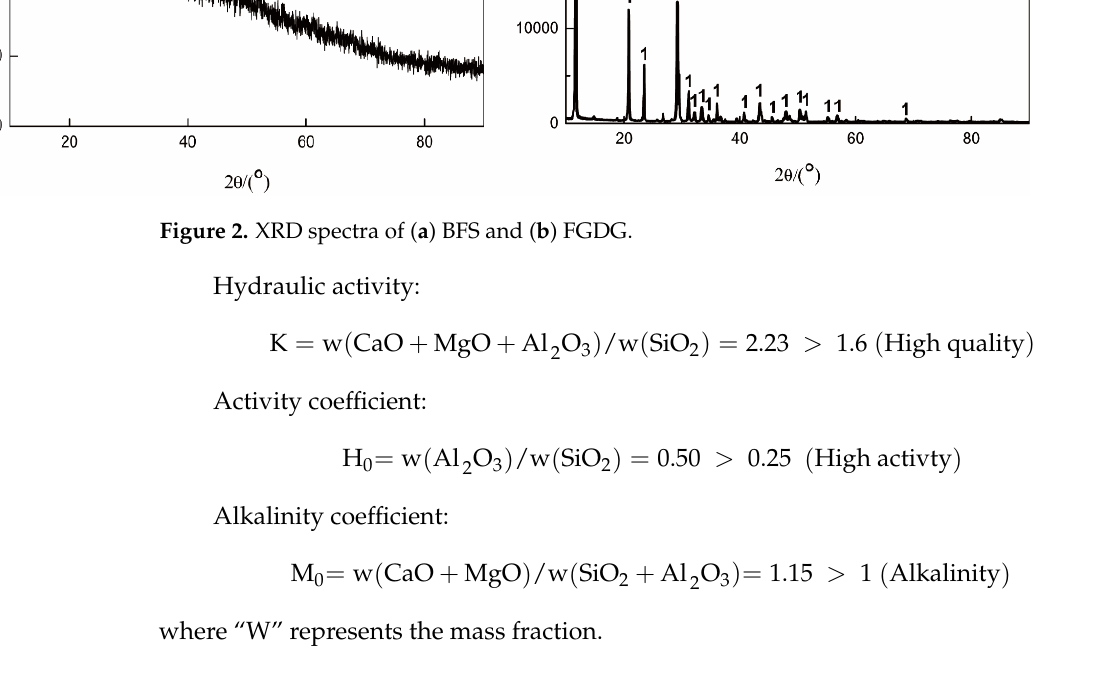
Table 3. XRF results of BFS and FGDG (%).